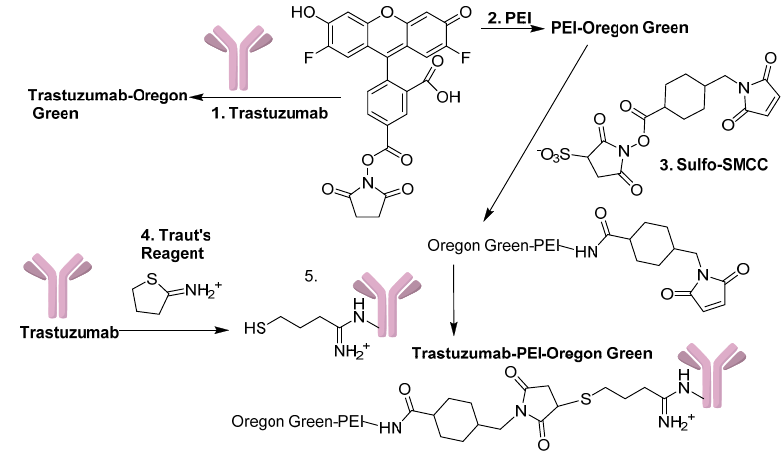
Figure 1. Synthesis scheme used to make PEI-OG, Trastuzumab-OG, and Trastuzumab-PEI-OG. (1) and (2) NaHCO 3 pH = 8.3, (3) PBS pH = 7.4, 5 h, (4) PBS/0.005 M EDTA (pH = 8.0) 30 min, and (5) PBS/0.005 M EDTA (pH = 7.4) 6